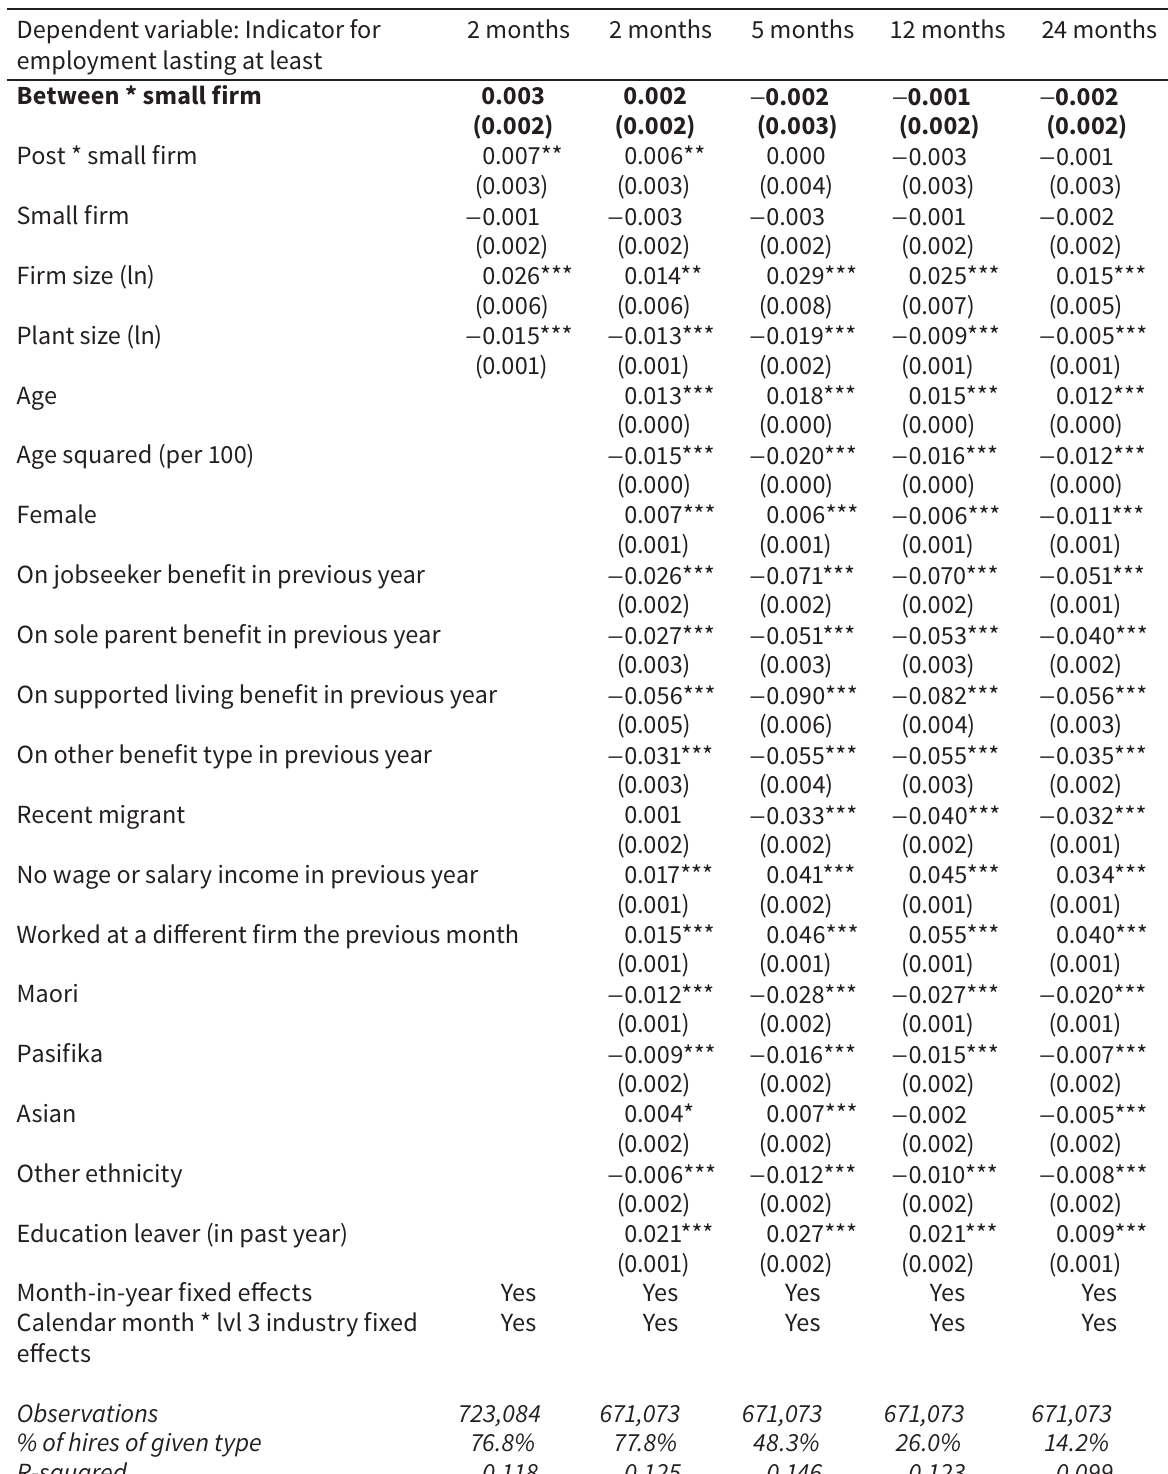
Policy effect on the distribution of employment duration of new hires Dependent variable: Indicator